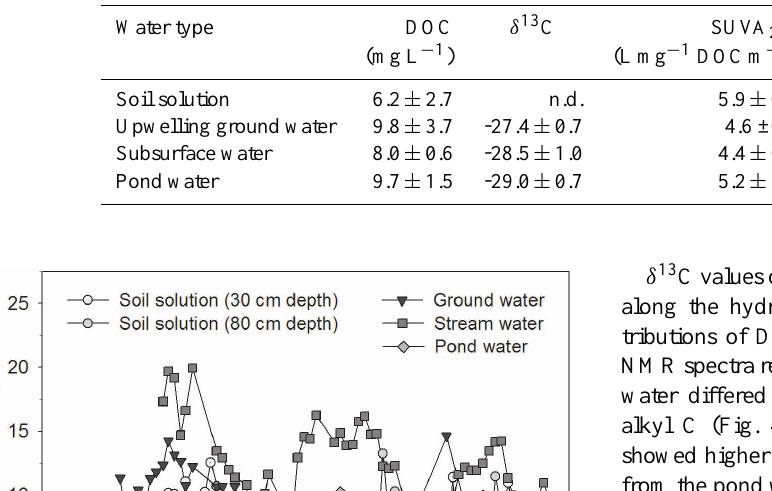
Table 2. Chemical properties of DOC in soil solution, upwelling ground water, subsurface water and pond water of the Chicken Creek Catch- ment in April 2010. Data are means ± 1 SD, n = 3. n.d. = not determined. Carbohydrates include monosaccharides (aldoses and ketoses) and oligo- and polysaccharides; concentrations are reported inmg glucose equivalents L − 1 .